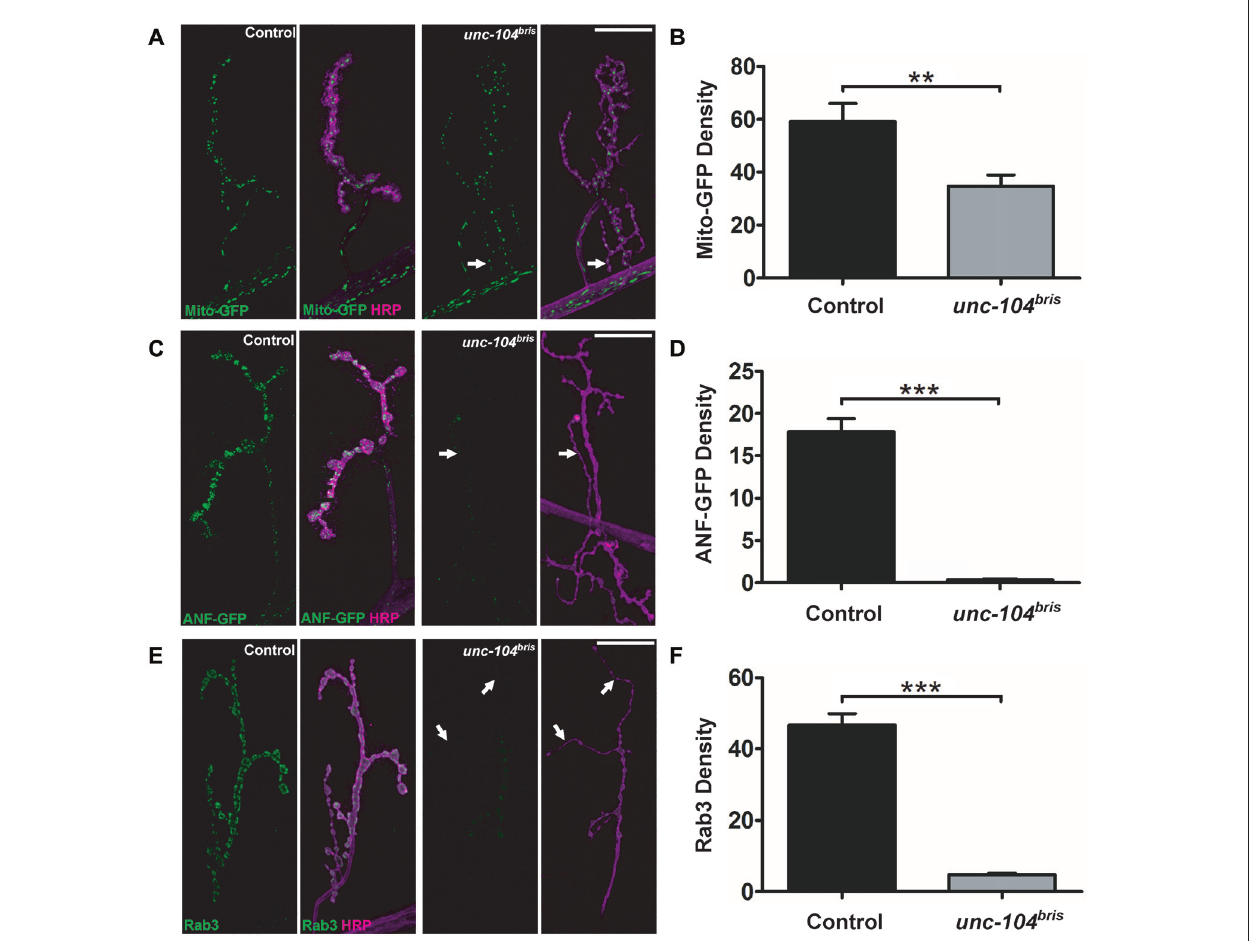
FIGURE 5 | Synaptic abundance of different cargoes at the NMJ of unc-104 bris mutants. Confocal images of NMJs in control and unc-104 bris mutant larvae expressing mito-GFP (green, in A ) or dense core vesicle (DCV) marker GFP tagged atrial natriuretic factor (ANF-GFP; green, in C ) induced by the D42-Gal4 driver. (A) mito-GFP localization was only mildly affected in unc-104 bris mutant NMJs (per HRP area; Mito density). (C) In contrast, ANF-GFP was barely present in unc-104 bris mutant NMJs (per HRP area; ANF-GFP density) compared to control NMJs (per HRP area). Quantifications (in a.u.) of mito-GFP (B) and ANF-GFP (D) per HRP area respectively as seen in (A,C) . Mito-GFP abundance in unc-104 bris mutant NMJs decreased slightly (control: 59.09 ± 6.84 a.u.; unc-104 bris : 34.77 ± 4.13 a.u., p < 0.01) whereas ANF-GFP in unc-104 bris mutant NMJs dropped to only 2% of control (control: 17.84 ± 1.56 a.u.; unc-104 bris : 0.34 ± 0.10 a.u., p < 0.001). (E) Immunostaining of Rab3 (green in E ) reveals that its quantity also decreased significantly at unc-104 bris mutant NMJs. (F) Quantification of Rab3 at the NMJs (per HRP area; Rab3 density) shown in (E) in a.u. (control: 46.69 ± 3.25 a.u.; unc-104 bris : 4.77 ± 0.46 a.u., p < 0.001). N = 9–13 NMJs in each group. Genotypes: in (A,B) control (;; D42-Gal4, UAS-mito-GFP/+ ), unc-104 bris (; unc-104 bris /unc-104 d 11024 ; D42-Gal4, UAS-mito-GFP/+ ); (C,D) control (;; D42-Gal4, UAS-anf-GFP/+ ), unc-104 bris (; unc-104 bris /unc-104 d 11024 ; D42-Gal4, UAS-ANF-GFP/+ ); (E,F) control ( w1118 ), unc-104 bris (; unc-104 bris /unc-104 d 11024 ;). Experiments were